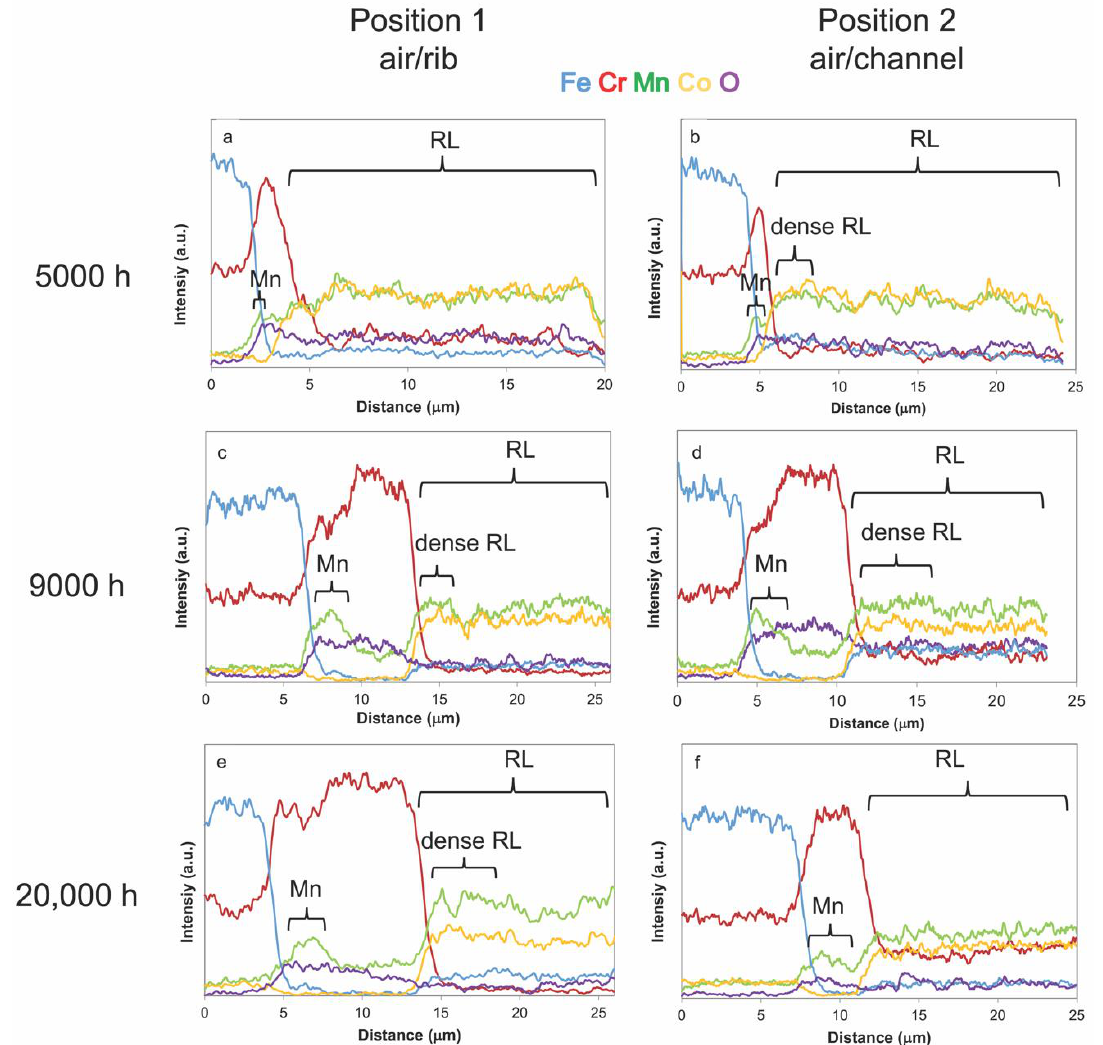
Figure 5. Linescans profiles of di ff erent sites of interest based on the K α energies of Cr, Mn, Fe, Co, O of the di ff erent positions: ( a ) IN sample at 5000 h position 1; ( b ) IN sample at 5000 h position 2; ( c ) IN sample at 9000 h position 1; ( d ) OUT sample at 9000 h position 2; ( e ) OUT sample at 20,000 h; ( f ) IN sample at 20,000 h RL = reaction layer. Figure S3 displays the SEM images and the sites of the analyses. The distance refers to the initial spot of analysis in the metal substrate (on the left of the black line) as shown by the presence of Fe as major element.